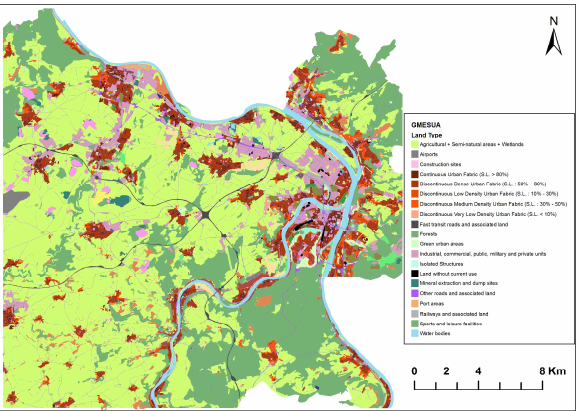
Figure 2: The achieved land use map of